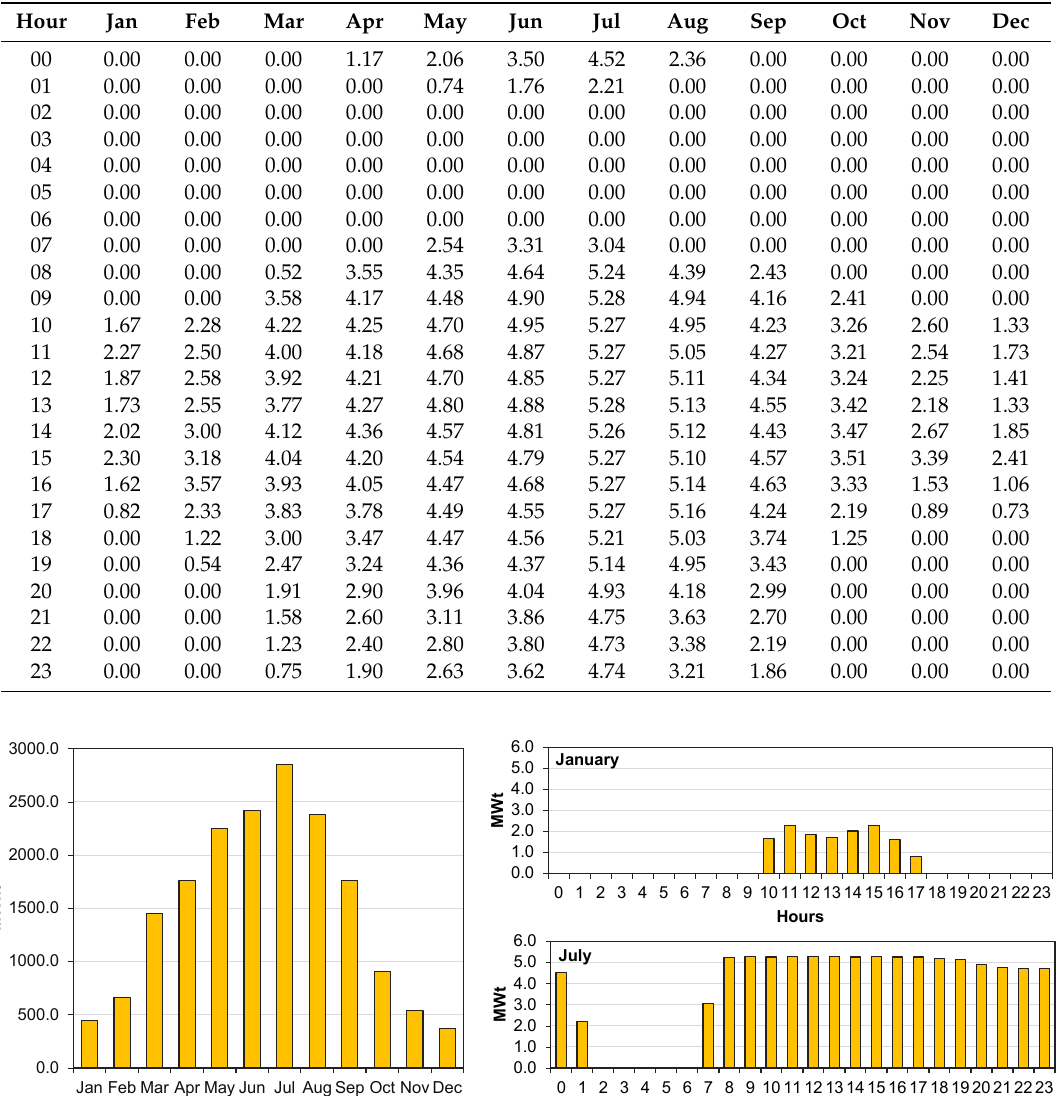
Table 4. Hourly values of thermal power (MW t ) provided by the solar system (#2) of the solar parabolic trough–ORC plant (system B).